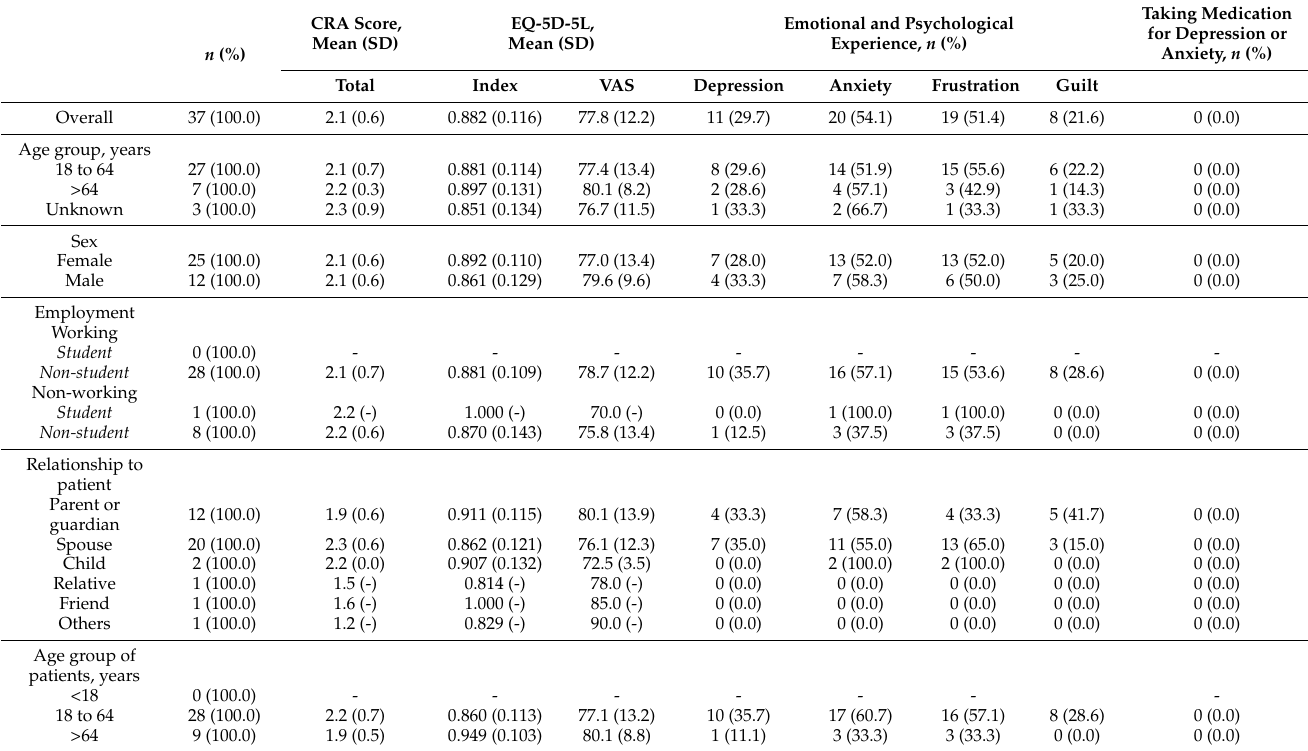
Table 4. Quality of life impacts on caregivers of patients with retinitis